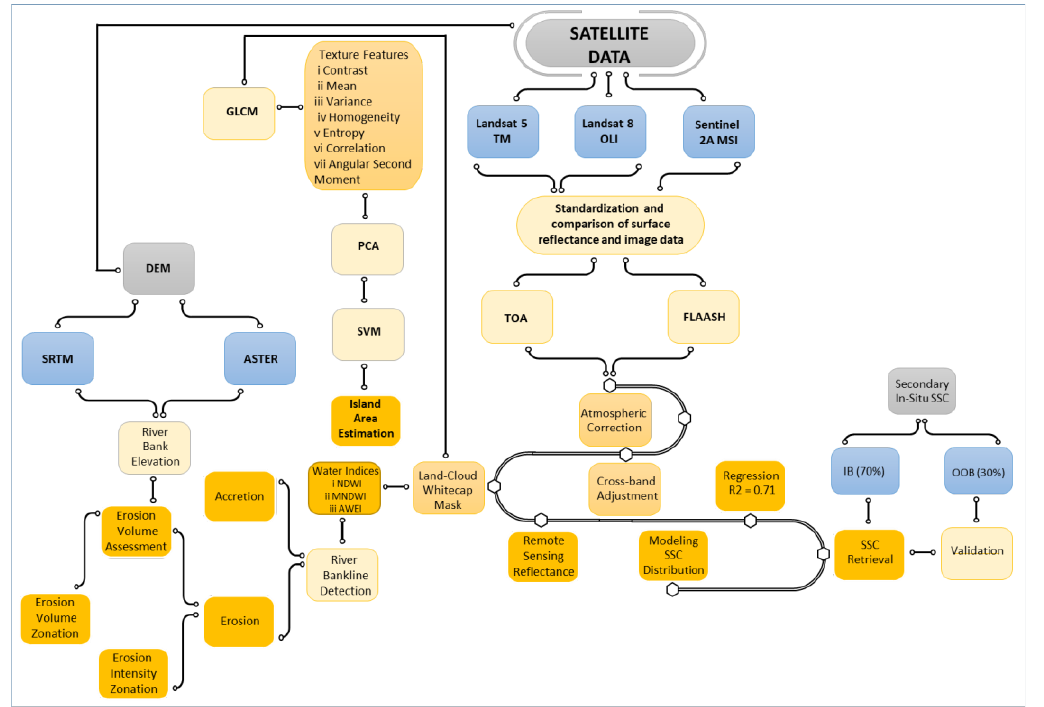
Figure 2. A flow chart depicting the methodology of the sediment erosion - accretion, and SSC dis- tribution modelling. Explanations: SVM—support vector machine, GLCM—grey level co - occurrence matrix, NDWI—normalized difference water index, MNDWI—modified normalized difference water index, AWEI—automated water extraction index, FLAASH—fast line - of - sight atmospheric analysis of hypercubes, TOA—top of atmosphere radiance, IB—sample taken In Bag, OOB—sample taken Out of Bag, NIR—near - infrared reflectance.